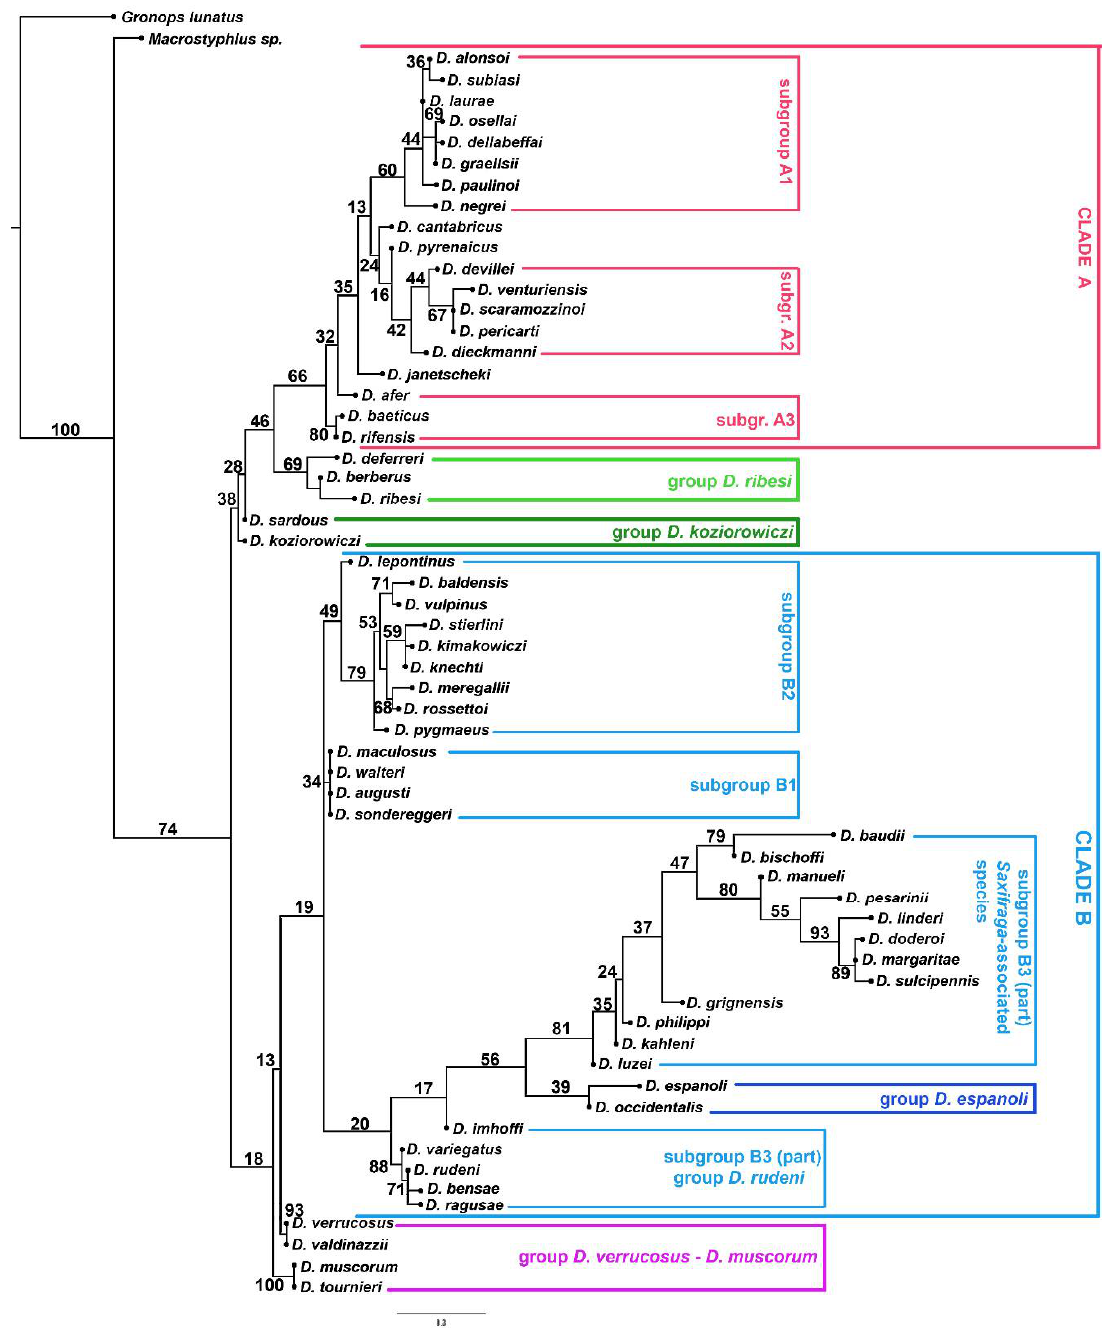
Figure 5. Morphological analysis. Maximum Likelihood consensus tree. Numbers above branches indicate bootstrap value. Scale bar unit: expected changes of state per character. Clades and species group are indicated as shown by the Bayesian analysis.